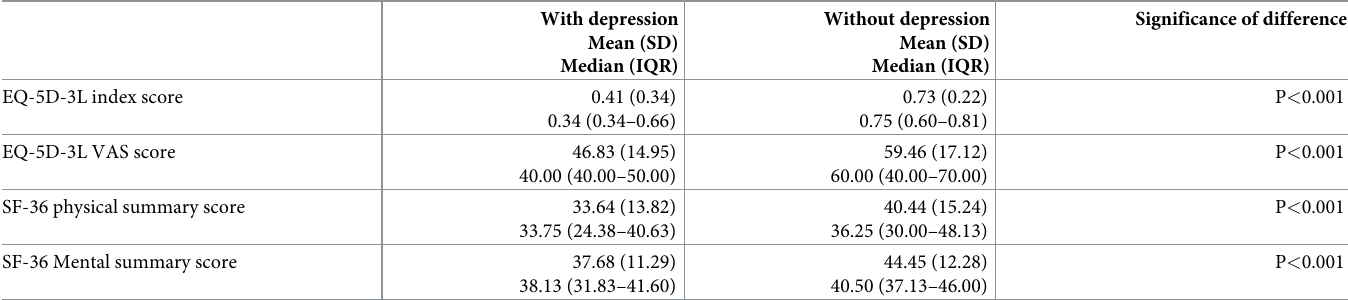
Table 5. Known group comparison among participant with or without depression with SF-36 summary scores and EQ-5D-3L scores.